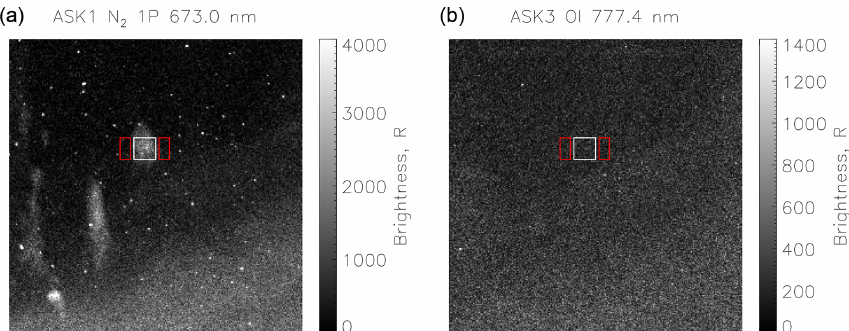
Figure 12. Simultaneous images in N 2 1P ( a ; ASK1) and OI 777.4nm ( b ; ASK3) at 19:04:19.063UT during event 1. The region used to calculate the brightness of a selected FAE is shown with a white box, and the regions used to calculate the background intensity are shown with red